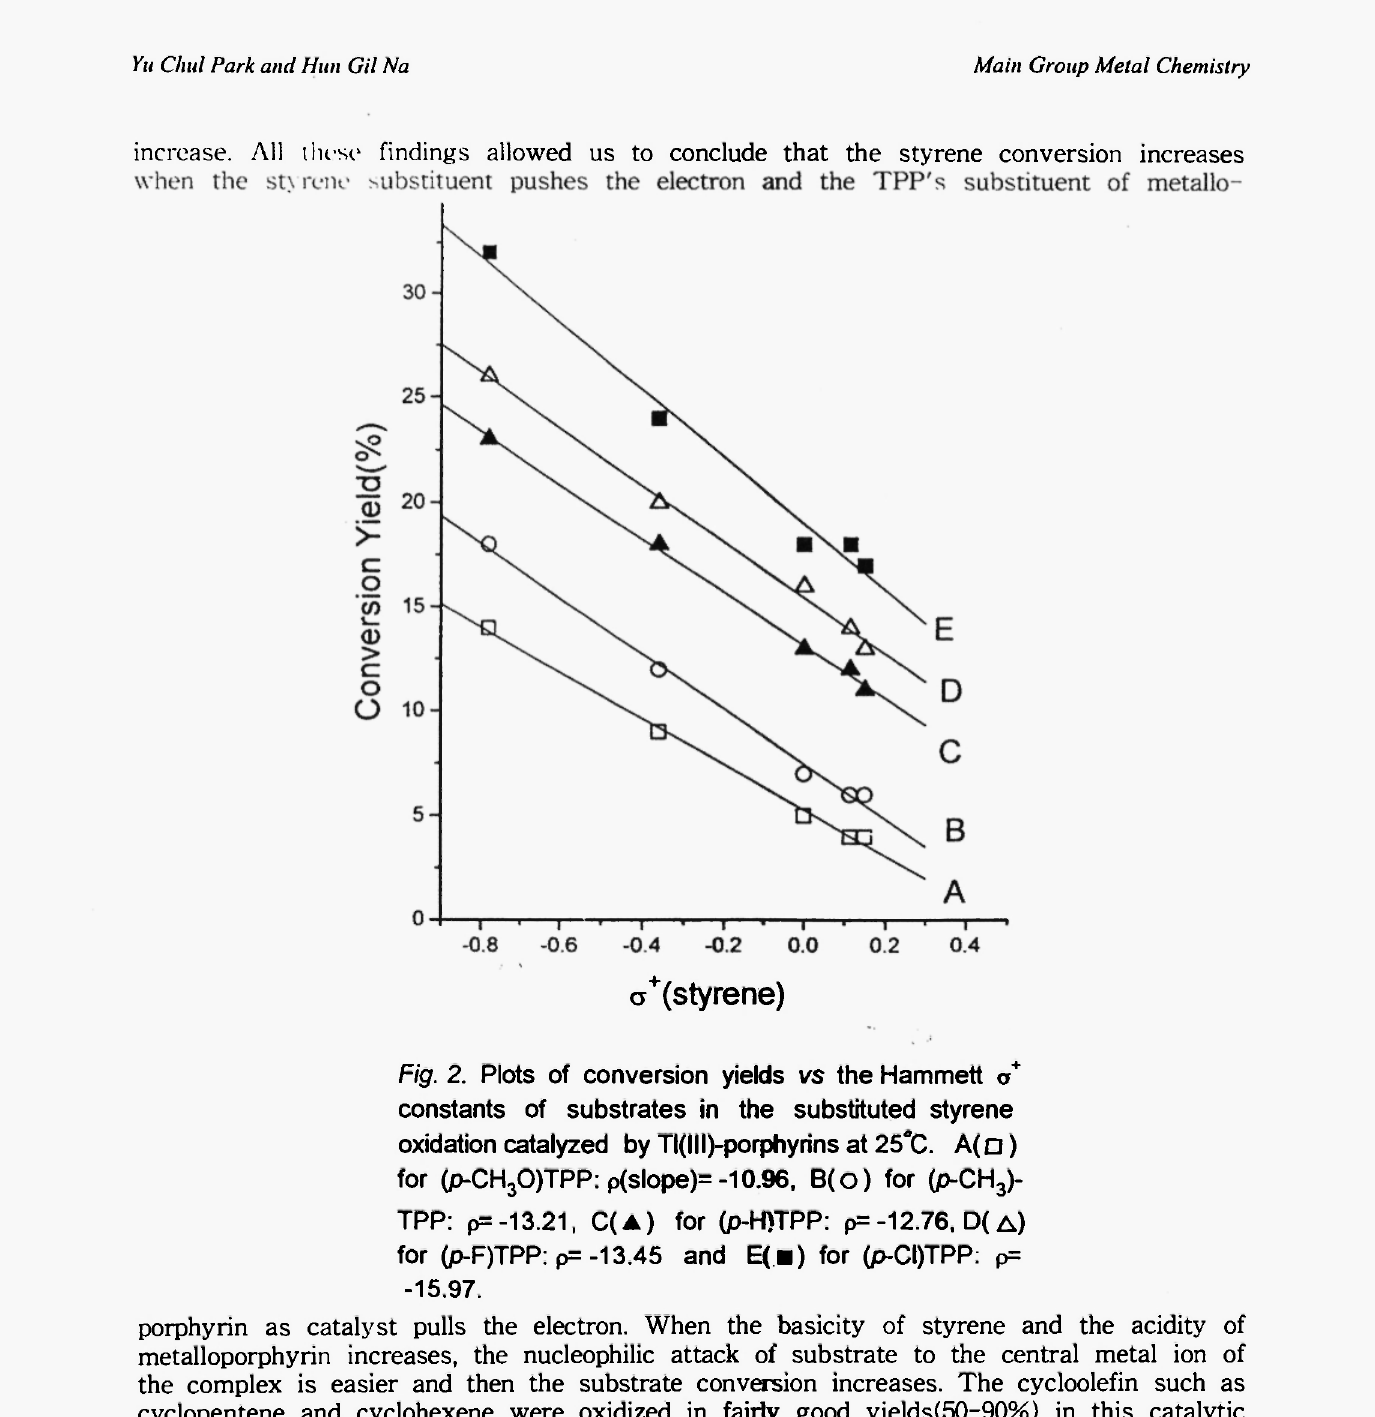
Fig. 2. Plots of conversion yields vs the Hammett σ + constants of substrates in the substituted styrene oxidation catalyzed by TI(lll)-porphyrins at 25°C. A(o) for (p-CH 0)TPP: p(slope)= -10.96. B(o) for (p- CH 3 TPP: p= -13.21, C(A) for (p -H)TPP: p= -12.76, D( A) for (p-F)TPP: p= -13.45 and E( ·) for (/>-CI)TPP: p=